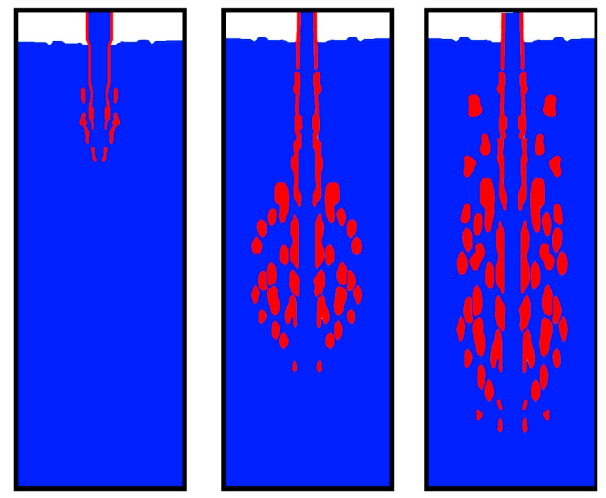
Figure 4. VOF Sequences of bubbly plume.